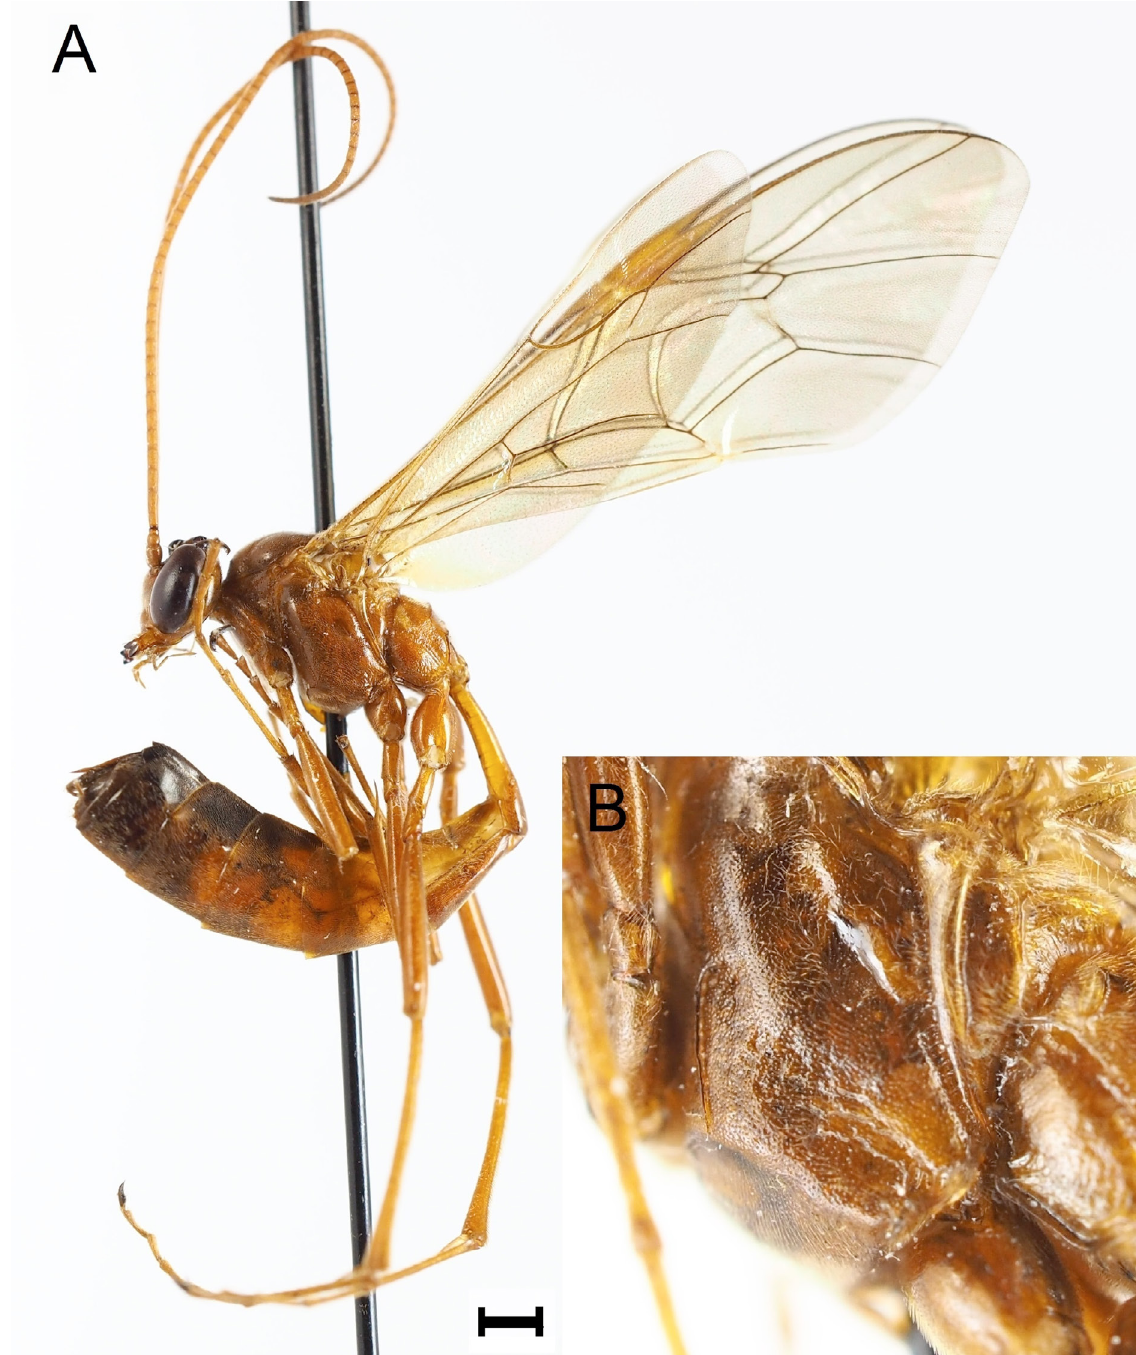
Fig. 24. Ophion artemisiae Boie, 1855, ♀. A . habitus, lateral view. B . Mesopleuron, lateral view. Scale bar: A = 1